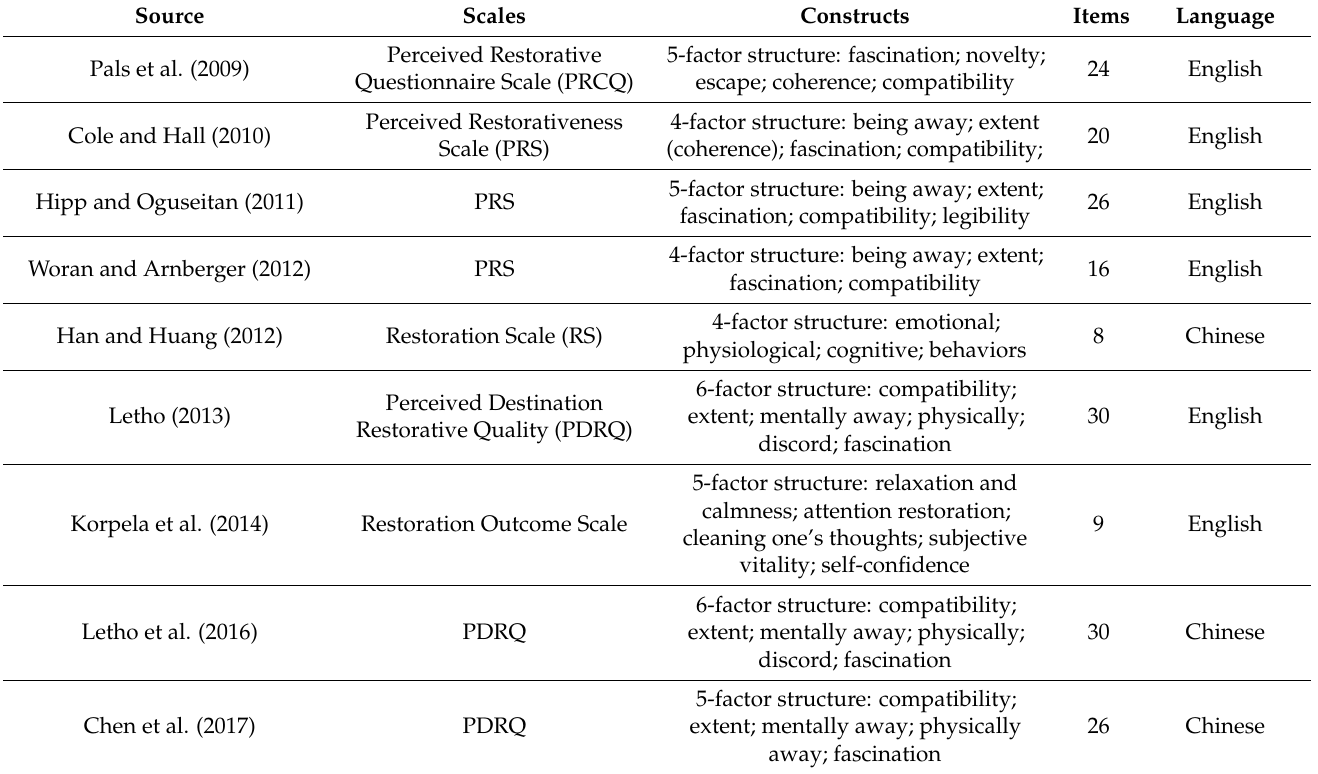
Table 4. Characteristics of the self-report